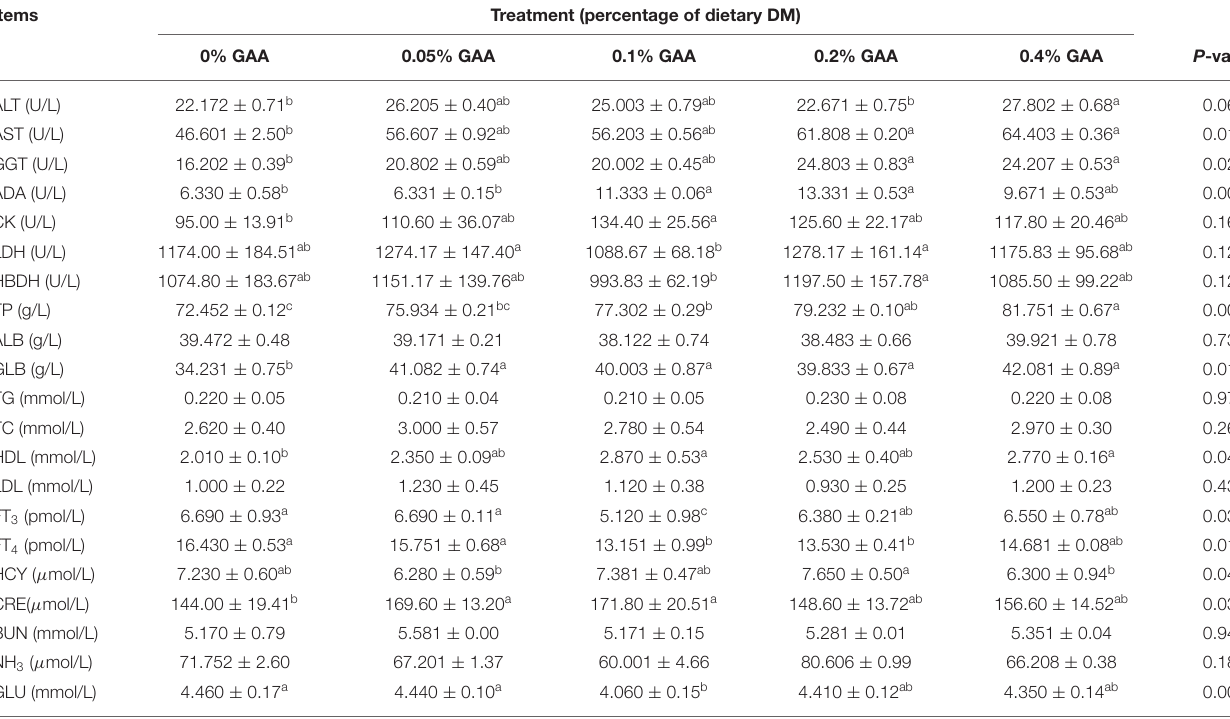
TABLE 4 | Effects of dietary GAA supplementation on blood biochemical variables of Jinjiang bulls.